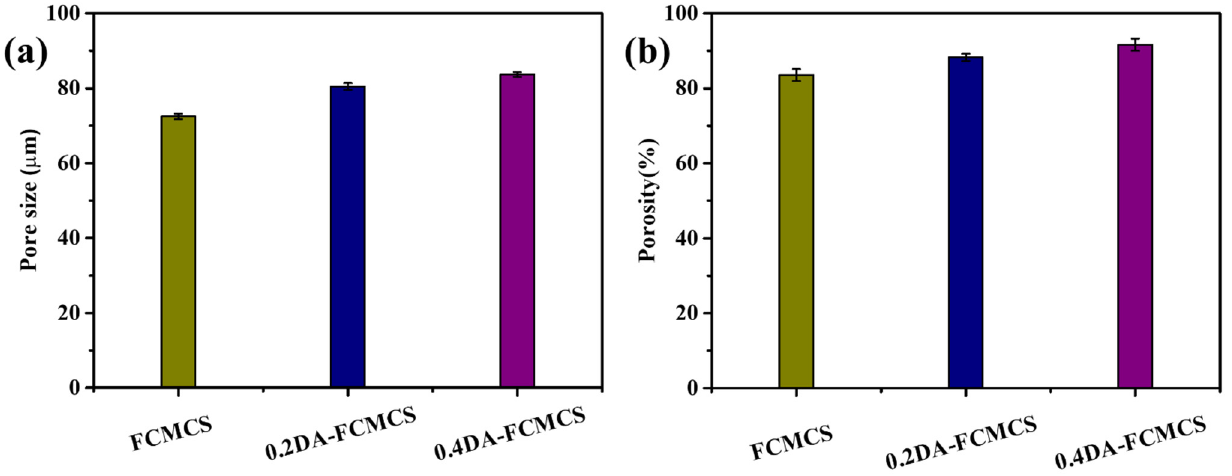
Figure 6. ( a ) Pore size and ( b ) porosity of hydrogels.